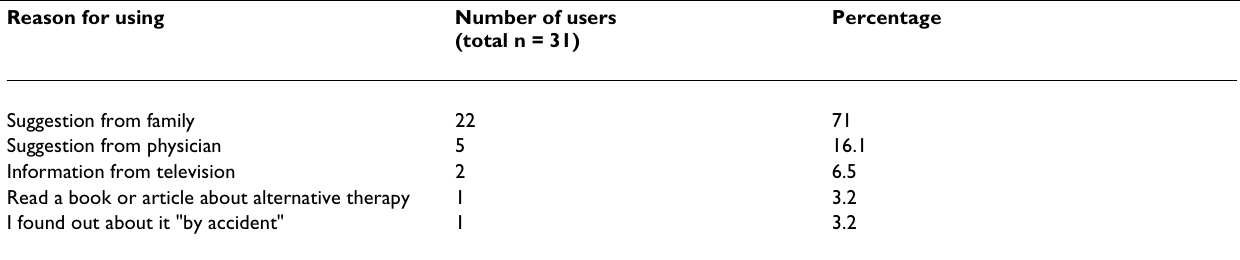
Table 2: Why patients used alternative therapies Reason for